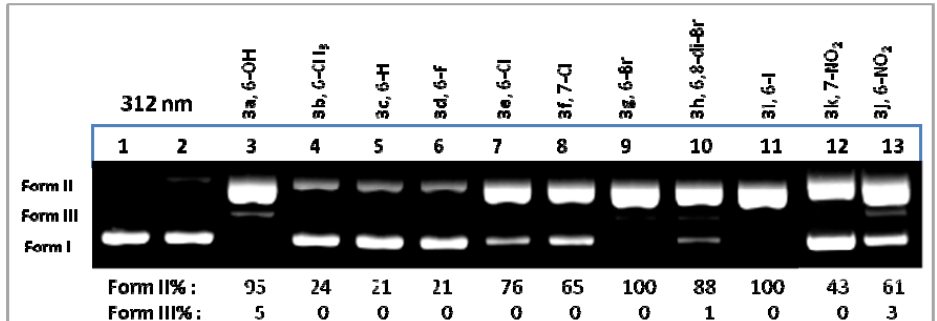
Figure 2. Efficiency on DNA photo-cleavage by QNZ derivatives 3a-3j and 3k at concentration of 500 μ M with UVB light (312 nm). Gel electrophoresis data: Lane 1: DNA without UV irradiation; Lane 2: DNA with UV irradiation; Lanes 3–13: as indicated at the top of the agarose gel.